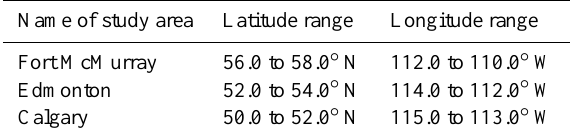
Table 1. The boundaries of the study areas.